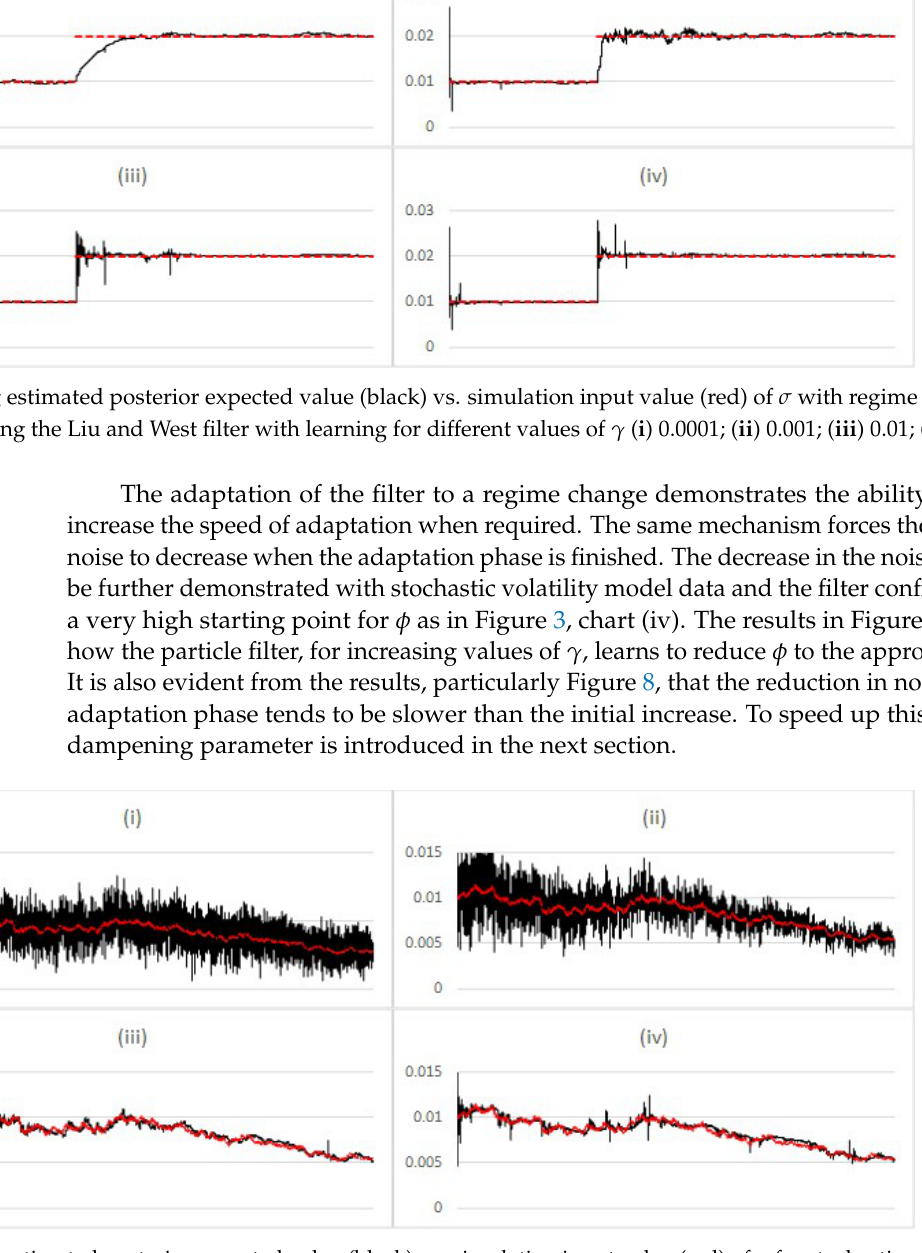
Figure 9. Comparing estimated posterior expected value (black) vs. simulation input value (red) of σ for stochastic volatility with learning for different values of γ ( i ) 0.0001; ( ii ) 0.001; ( iii ) 0.01; ( iv )